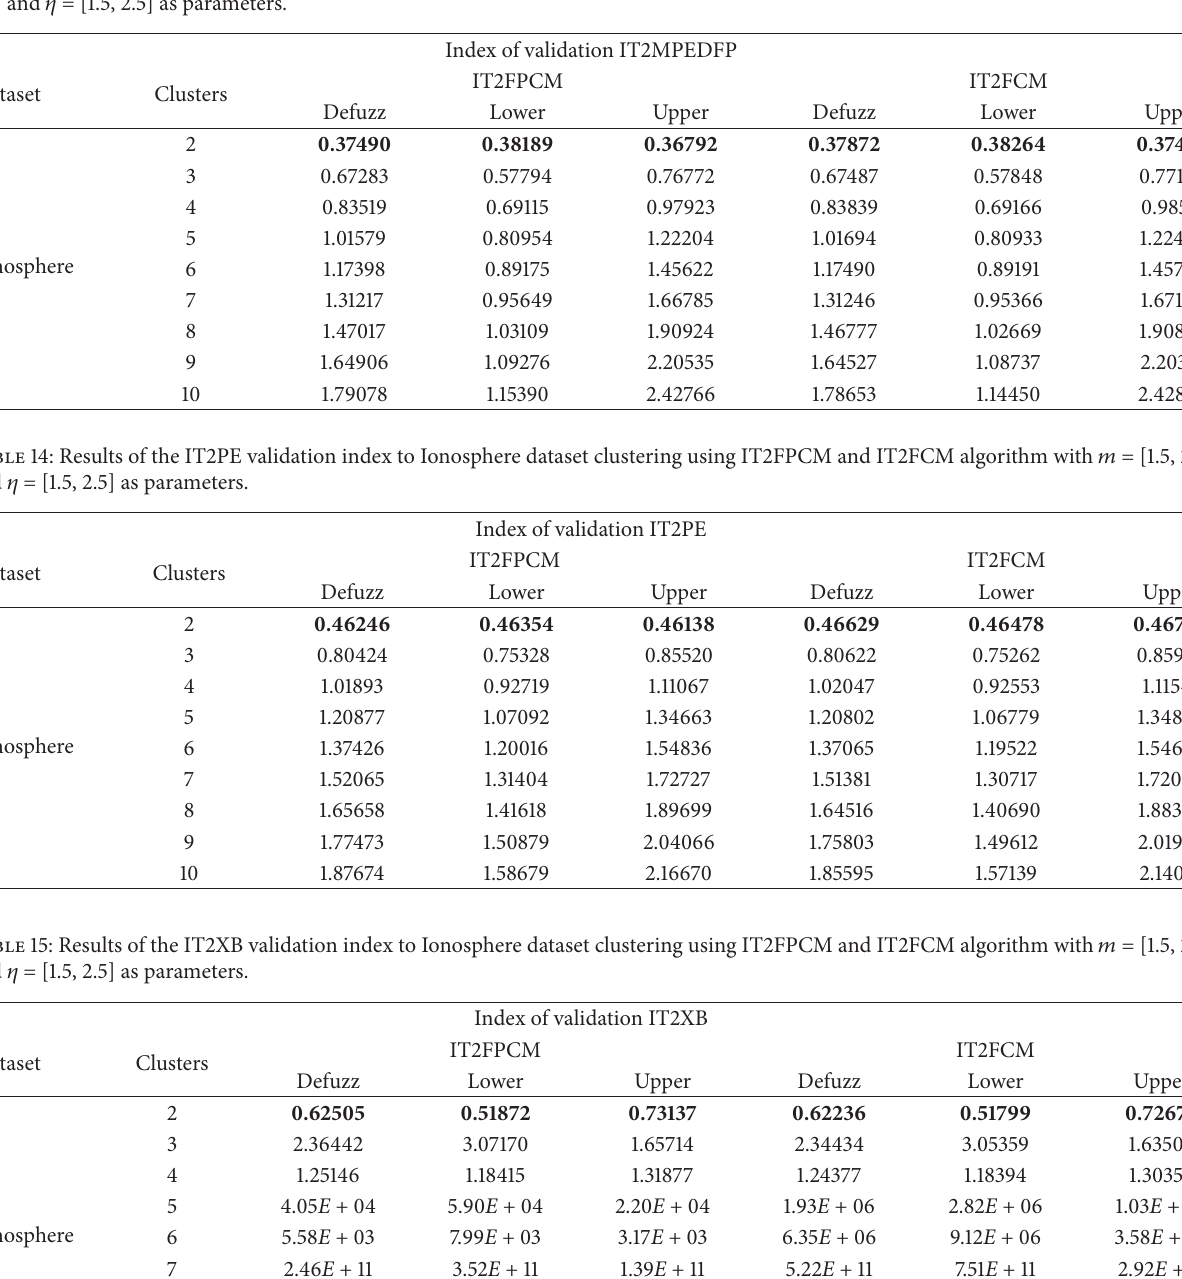
Table 13: IT2MPE-DMFP validation index results to Ionosphere dataset clustering using IT2FPCM and IT2FCM algorithm with 𝑚 = [1.5, 2.5] and 𝜂 = [1.5, 2.5] as parameters.